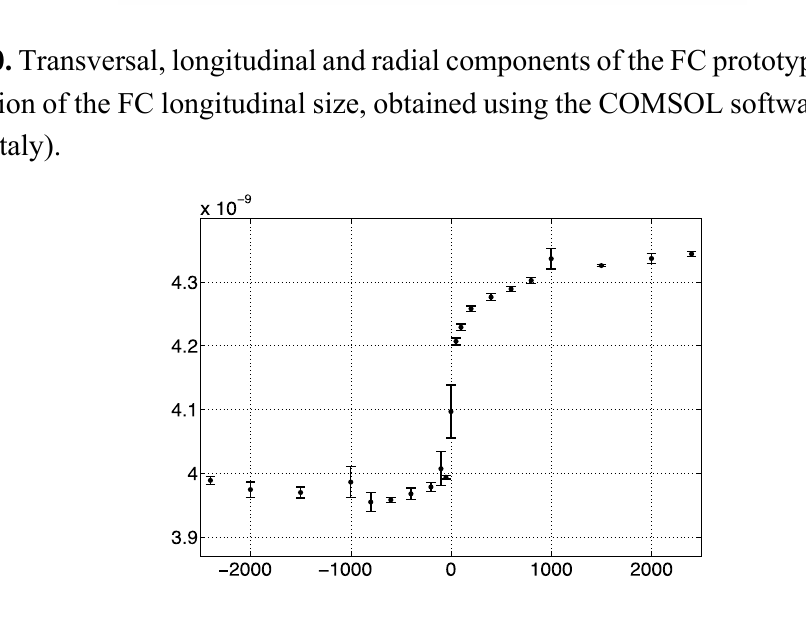
Figure 11. Charge collected by the FC prototype as a function of the bias applied to the external